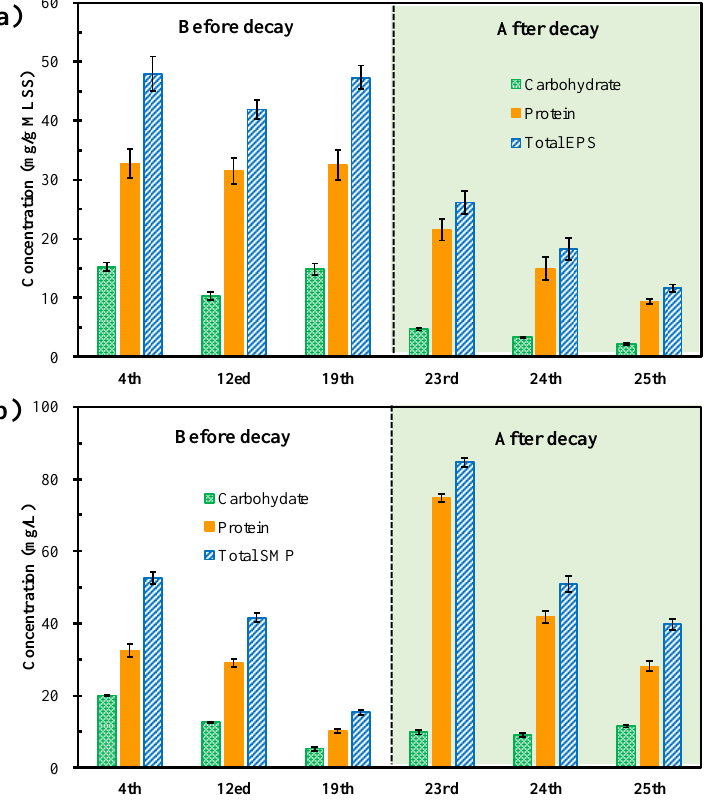
Figure 6. Comparison of the ( a ) EPS and ( b ) SMP content before and after decay.